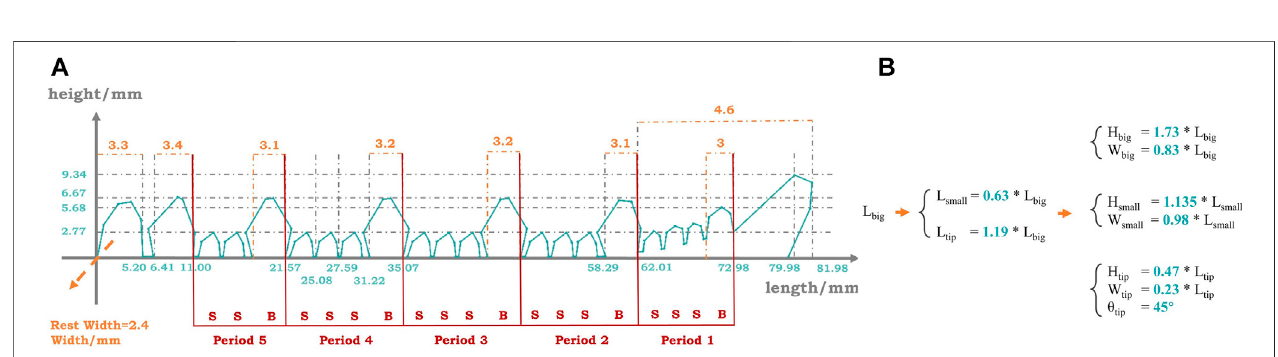
FIGURE10|(A) Quantitative detail and periodicanalysisofthe teethon thecutter. (B) Mathematicalexpression:thequantitativerelationship between theteeth on the cutter, with the numeric parameter in blue sampled from a specimen.